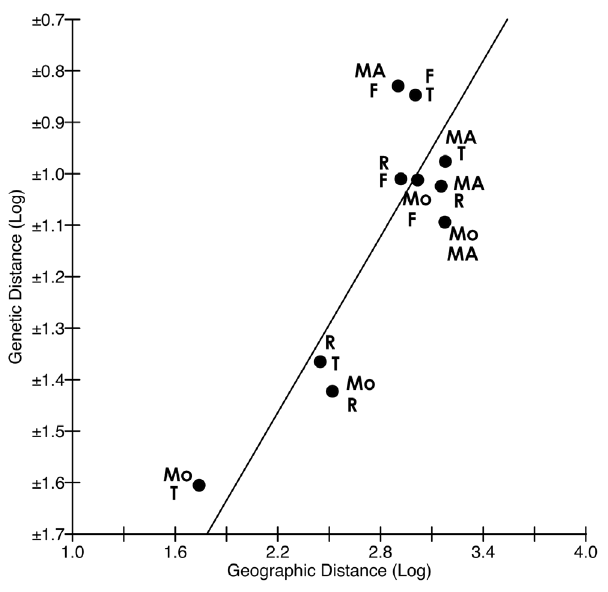
Figure 3. Isolation by Distance graph comparing geographic and genetic distance. Jackknifing slope over the 5 demes is 0.3654 6 0.275 (SE). The data points denote two-location comparisons: Mo=Moorea, R=Rangiroa, F=Fakahina, T=Tetiaroa and Ma=Maria (R2=0.739). restrict (Fakahina)/extrapolate (Moorea, Tetiaroa, Rangiroa, Maria) the number of samples used for the analysis to 40. The